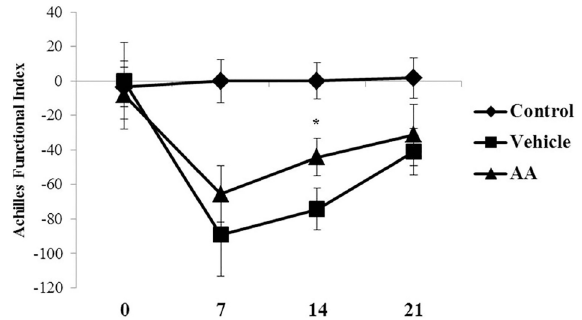
Figure 3. Achilles functional index was measured at 0, 7, 14, and 21 days post-surgery in control, vehicle, and ascorbic acid (AA) groups. Data are reported as means ± SD for n=6. *P o 0.05 vs vehicle (ANOVA and Tukey ’ s